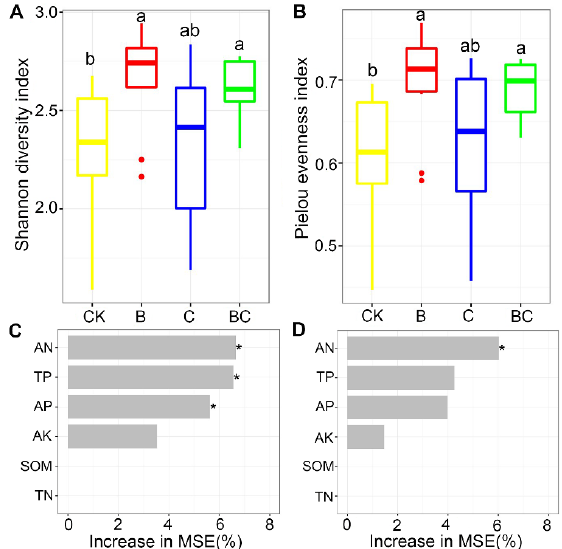
Figure 2. Arbuscular mycorrhizal (AM) fungal Shannon diversity indices ( A ) and Pielou evenness indices ( B ) among treatments; random forest mean predictor importance of soil variables on AM fungal Shannon diversity indices ( C ) and Pielou evenness indices ( D ). Abbreviations: CK, control; B, biochar addition; C, compost addition; SOM, soil organic matter; TN, total nitrogen; AN, available nitrogen; TP, total phosphorus; AP, available phosphorus; AK, available potassium; *, p < 0.05. The dot in the figure represents outlier. Bars without shared letters indicate significant difference at p < 0.05. 3.3. AM Fungal Community Composition PERMANOVA analysis indicated that AM fungal community composition was sig- nificantly affected by biochar addition ( r 2 = 0.08, p < 0.001), while unaffected by compost addition and aggregate fractions. This result was also supported by PCoA ordination, where AM fungal community compositions only slightly overlapped between treatment BC and C, as well as between treatment B and CK (Figure 3A). Mantel test revealed that AM fungal community composition was significantly impacted by soil AN, and margin- ally impacted by soil AP. As shown by Venn diagram, there were up to 51 AM fungal OTUs (78.46%) shared among three aggregate fractions (Figure 3C). The large macroaggregate harbored the largest number of unique AM fungal OTUs, while there was only one unique OTU in microaggregate and no unique OTU in little microaggregate (Fig- ure 3C), respectively. At family level, the relative abundance of Diversisporaceae ( F = 7.65, p = 0.009) and Paraglomeraceae ( F = 6.34, p = 0.02) were significantly affected by biochar addition. The relative abundance of Paraglomeraceae was consistently lower in treatment B than in CK across all soil aggregate fractions, while the Diversisporaceae exhibited the opposite trend (Figure 3B). However, other AM fungal families were unaffected by compost or biochar addition.